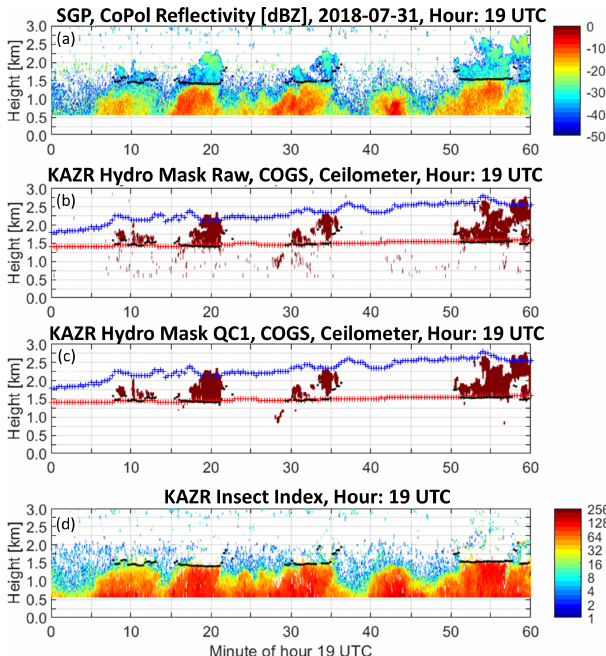
Figure 12. Measurements and retrievals for hour 19:00UTC on 31 July 2018. (a) CoPol reflectivity (dB). (b) Retrieved hydrome- teor raw mask (red shading). COGS-derived 6km × 6km domain average cloud base (red symbols) and cloud top (blue symbols). (c) Same as panel (b) expect for the retrieved hydrometeor QC1 mask. (d) Retrieved insect activity index. The black symbols are ceilometer-derived cloud